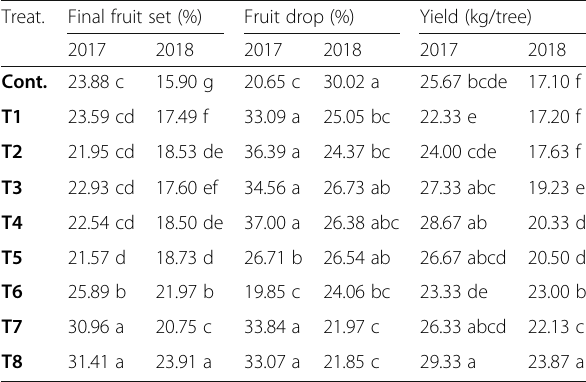
Table 5 Effect of foliar application of B 2 O 3 and ZnO nanoparticles on fruit yield traits of Picual cultivar in 2017 and 2018 seasons Treat. Final fruit set (%) Fruit drop